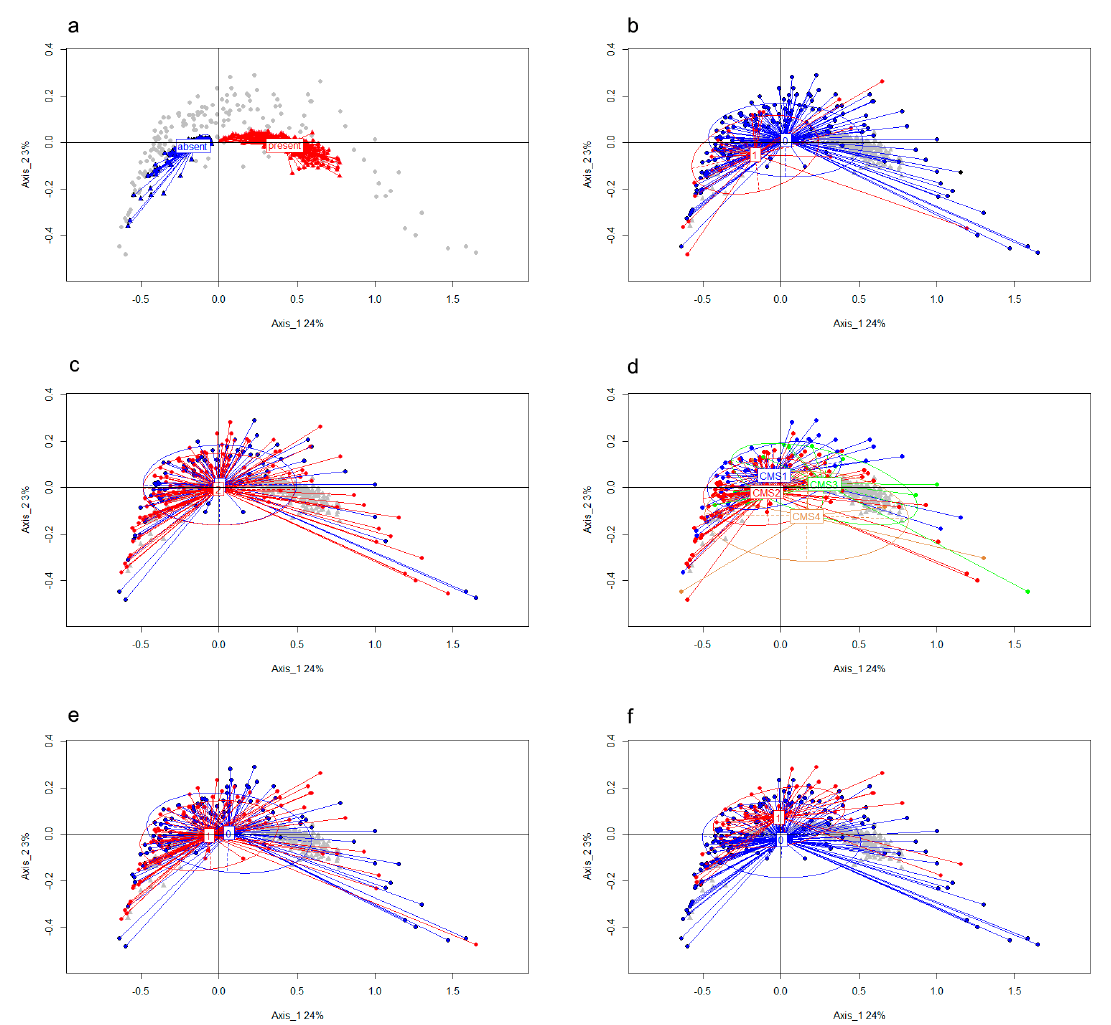
Figure 4. MCA analysis plots in which samples (closed circles) and circRNAs (triangles) are projected onto the same plane. ( a ). Blue and red indicate circRNAs without (absent) or with (present) circRNA expression, where similarity of two circRNA expression profiles (either both present (both red), both absent (both blue), or mutually exclusive (one red and one blue)) over the samples results in a small relative distance between these circRNAs. ( b ). Samples are colored based on relapse status, red indicates patients who relapse (1) showing circRNA profiles that are close to the “circRNA absent” group. ( c ). Samples are colored based on tumor stage I (blue) or stage II (red) showing no clear distinction in circRNA profiles. ( d ). The consensus molecular subtype (CMS) of the samples are indicated. CMS3 samples are most closely located to the “circRNA present” group. ( e ). Samples colored based on tumor side (left = 0; in blue, right = 1; in red) and ( f ), based on microsatellite instability (MSI) (MSI = 1; in red, MSS = 0; in blue).